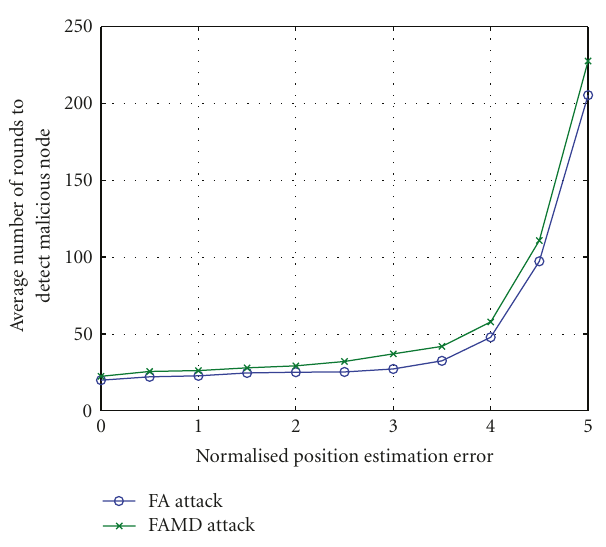
Figure 16: Impact of Position Estimation Error.